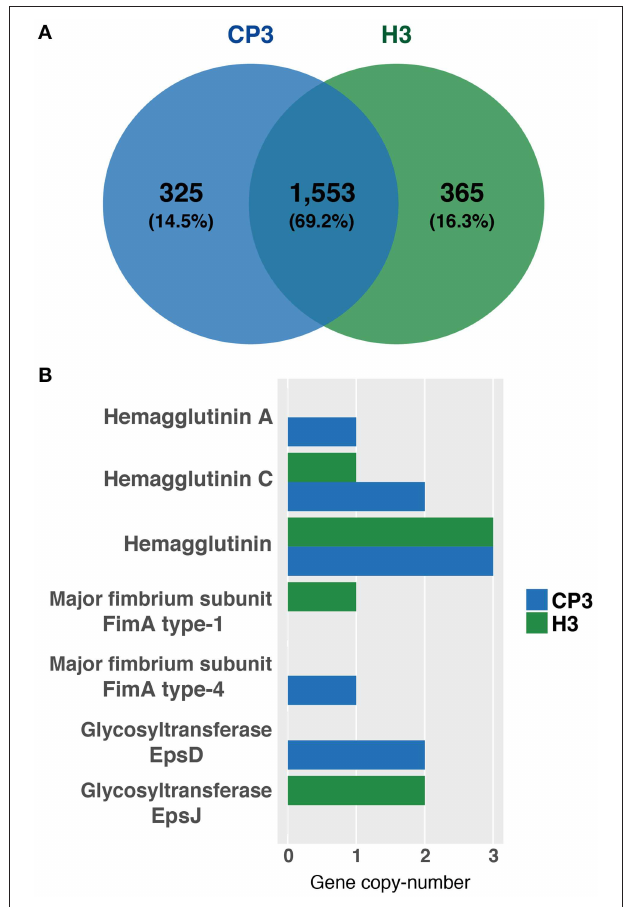
FIGURE 3 | Common genes between Porphyromonas gingivalis CP3 and H3 and differences in the copy-number of virulence genes. (A) Venn diagram showing the number of common and unique genes of CP3 (blue) and H3 (green) genomes. Values in parentheses are the percentage of genes of the total genes in CP3 and H3 pan genome. (B) Bar plot showing six virulence genes that we detected to have differences in their copy-number between CP3 (blue bars) and H3 (green bars) genomes.